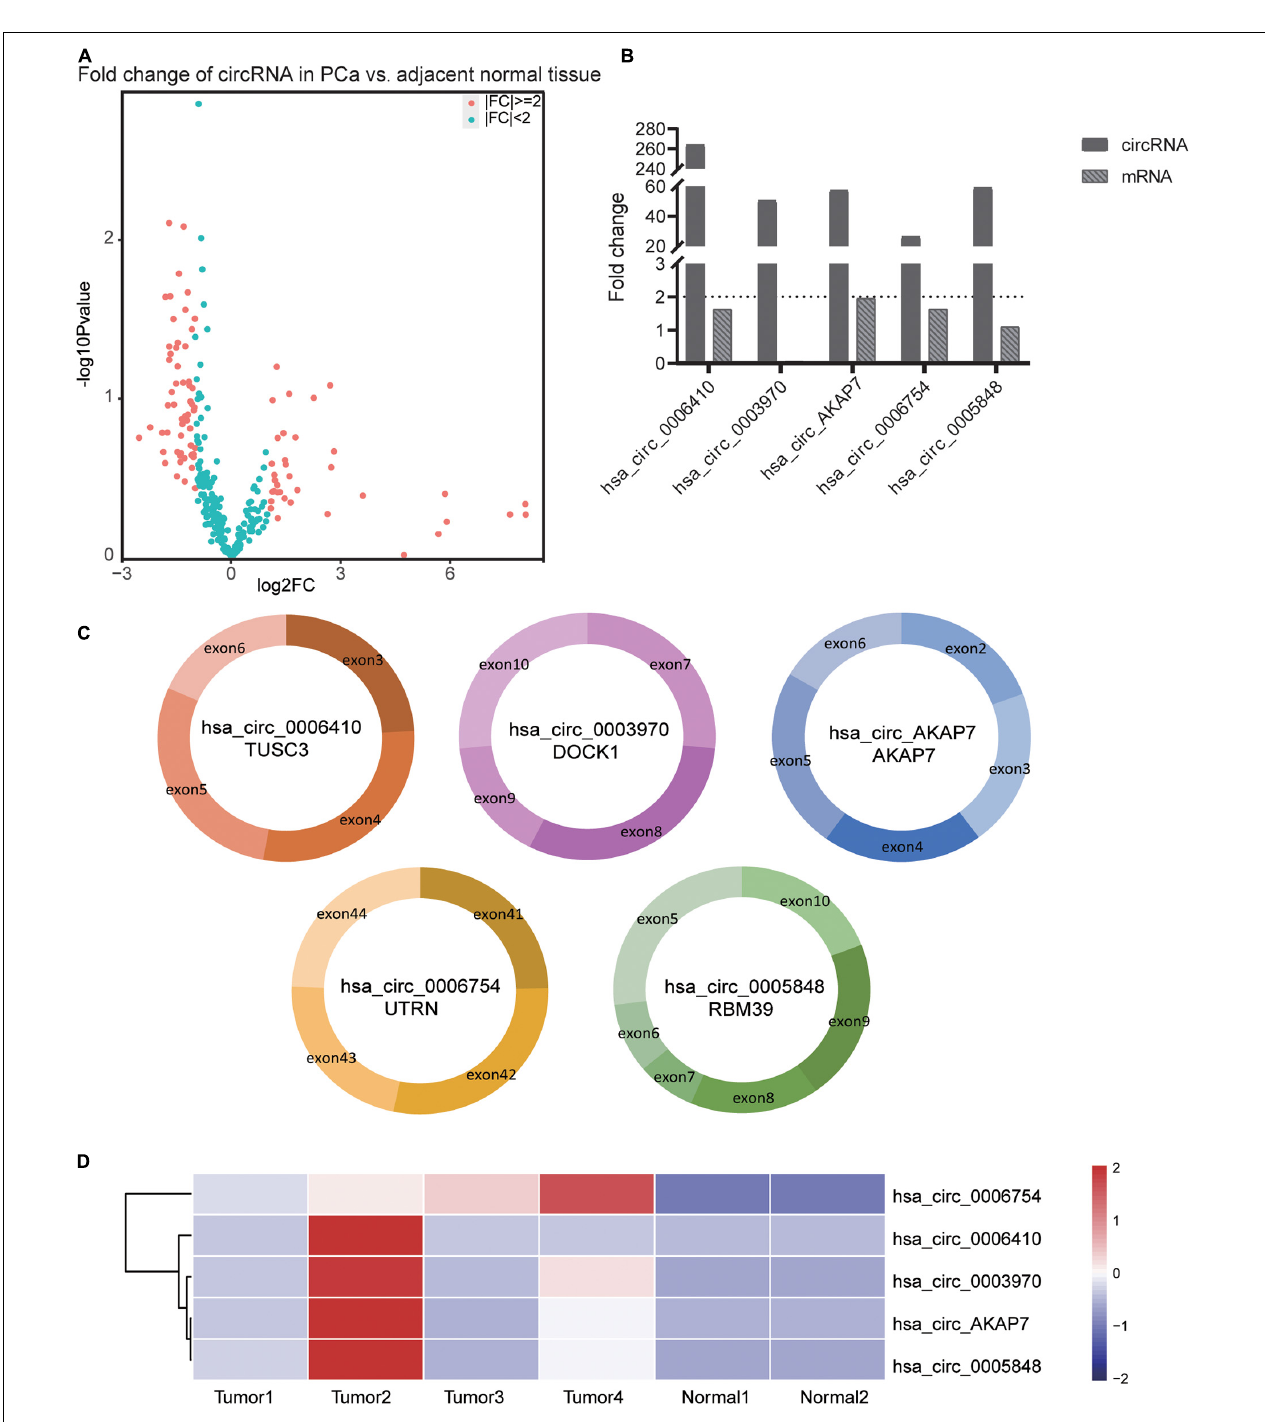
FIGURE 2 | Information of the five PCa specific circRNAs. (A) Volcano plot of circRNAs in PCa. The red points represent differentially expressed circRNAs in PCa with fold-change > 2 or fold-change < 0.5. The paired t -test was used to obtain p -value. (B) The fold-change of circRNAs and its cognate mRNA expression between tumor tissue and adjacent normal tissue. The fold-change of circRNAs was much higher than its mRNAs especially in hsa_circ_0006410. In both tumor as well as normal samples, the expression of hsa_circ_0003970 cognate mRNA was 0. Thus, the mRNA fold change of hsa_circ_0003970 was 0. (C) The exon composition of hsa_circ_0006410, hsa_circ_0003970, hsa_circ_0006754, hsa_circ_0005848, and hsa_circ_AKAP7. (D) Heatmap of the expression of five specific circRNAs. These five circRNAs are highly expressed in tumor tissues than in normal tissues. The value used in this figure is the expression of circRNAs, and we used “scale = row” to make the graph more